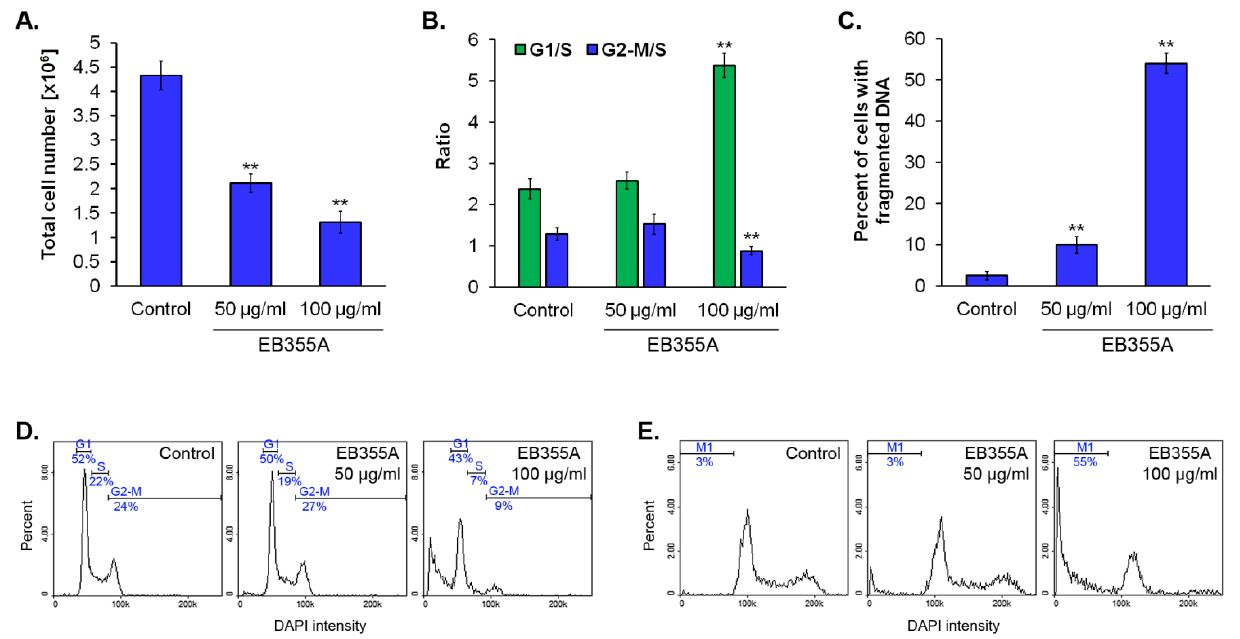
Figure 4. The effect of EB355A on breast cancer MCF-7 cells. The cells were treated with the compound for 72 h and then analyzed using an image cytometer. Graphs the represent mean ± standard deviation of 3 independent experiments completed in triplicate from the cell count assay ( A ), cell cycle analysis ( B ), and DNA fragmentation assay ( C ). ** p < 0.01 vs. control. Representative histograms depict the distribution of tested cells in the indicated cell cycle phases ( D ). Representative histograms from DNA fragmentation analysis, where M1 includes a subpopulation of cells with fragmented DNA ( E ).